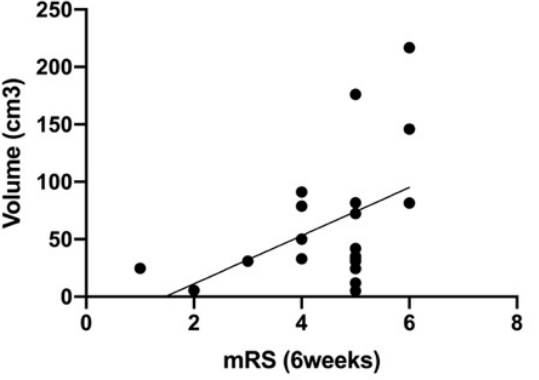
Figure 6. Correlation of mRS after 6 weeks and the volume of ICH at admission ( p = 0.05).